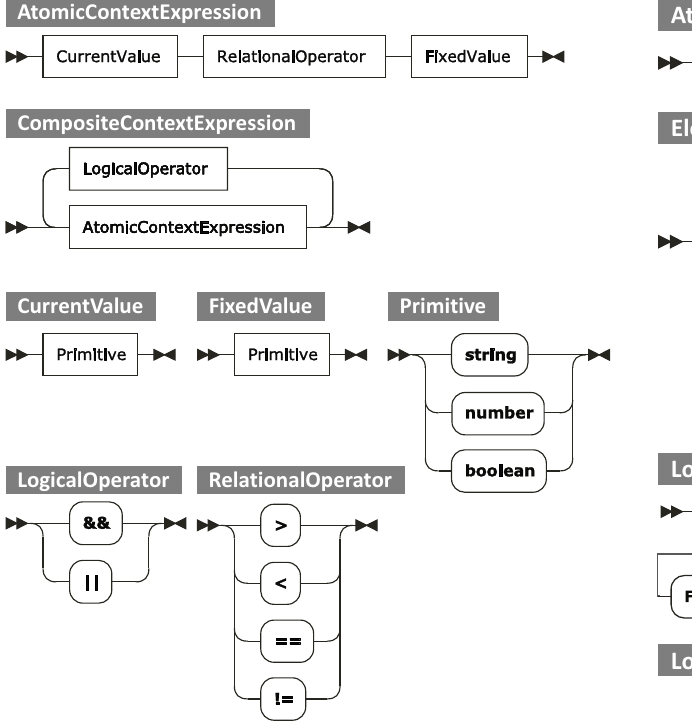
Figure 1. Syntax diagram of context expression (original version)